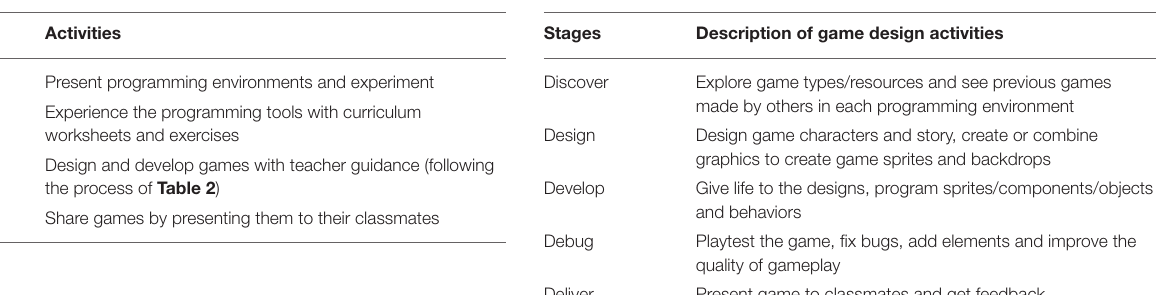
TABLE 1 | The 8-week workshop process followed. TABLE 2 | Game development process